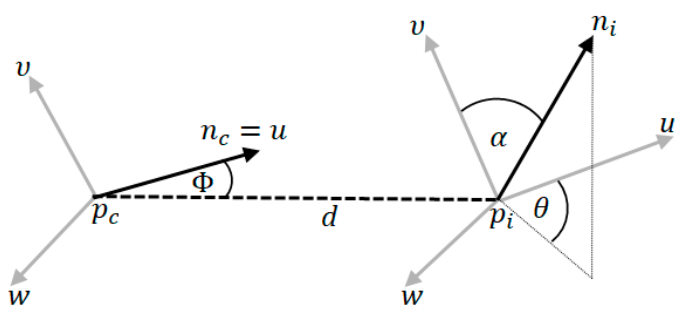
Figure 1. Values of the surface shape component of the Viewpoint Feature Histogram (VFH).